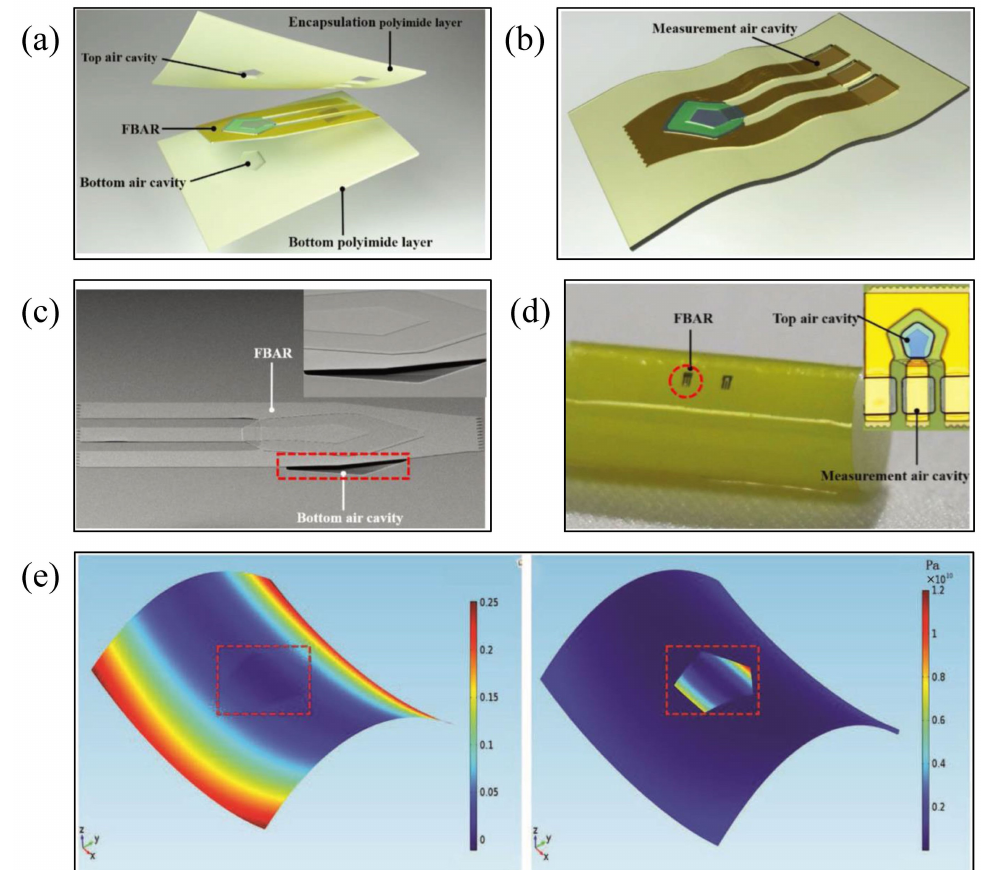
Figure 9. ( a ) Exploded-view image of the flexible device [100] Reprinted/adapted with permission from Ref. [100]. 2018, John Wiley and Sons. ( b ) Diagram of the FBAR embedded in double-layer PI film [100] Reprinted/adapted with permission from Ref. [100]. 2018, John Wiley and Sons. ( c ) SEM image of the FBAR with the bottom cavity structure [100] Reprinted/adapted with permission from Ref. [100]. 2018, John Wiley and Sons. ( d ) Photo of the flexible FBAR conforming to the surface of the cylinder [100] Reprinted/adapted with permission from Ref. [100]. 2018, John Wiley and Sons. ( e ) FEM analysis of the mechanical properties of the flexible FBAR under bending conditions [100] Reprinted/adapted with permission from Ref. [100]. 2018, John Wiley and